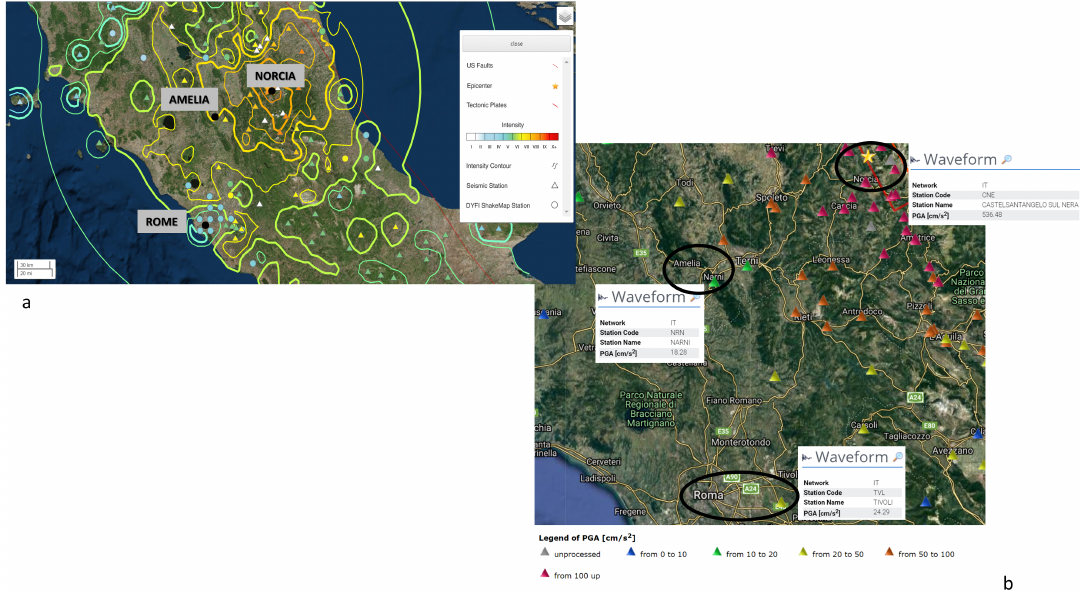
Figure 2. ( a ) The intensity of the Norcia 2016 earthquake (source USGS: http://earthquake.usgs.gov); ( b ) The peak ground acceleration (PGA) relative to the two study areas and the epicenter (source ITACA: